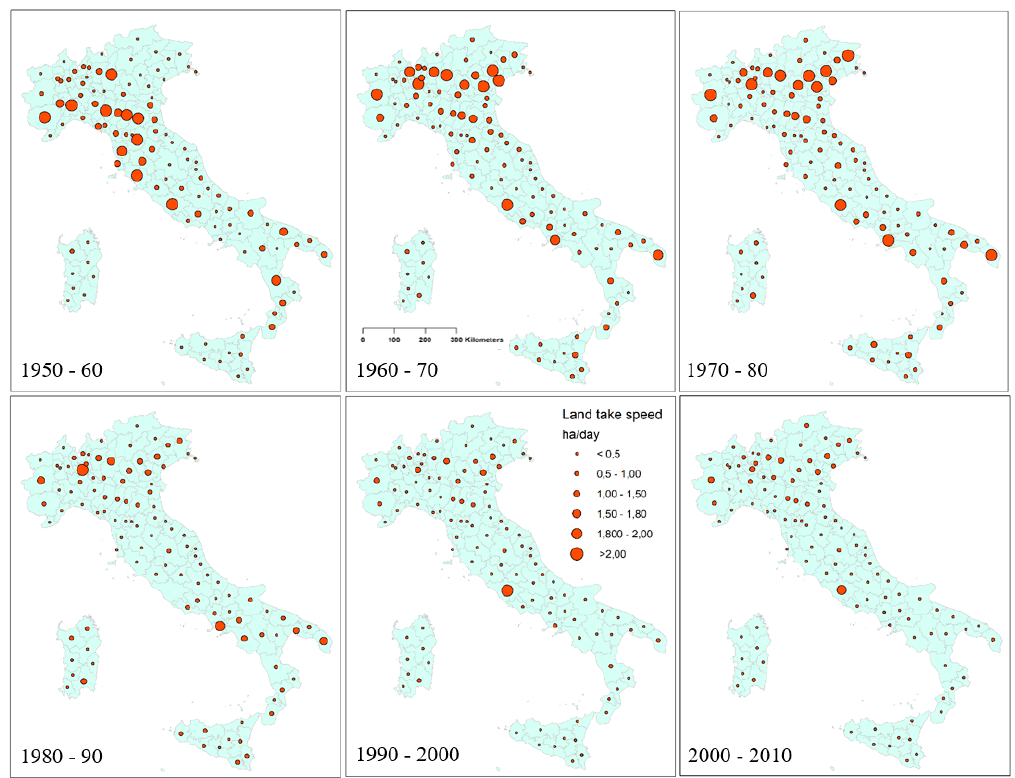
Figure 4. Geographical indication of urbanization rates calculated for the different periods analyzed. The application of equations [1] and [2] helps map urbanization density per time period and provincial district (NUTS 3) shown in Figure 5, as well as mean urbanization rates in the different periods analyzed.